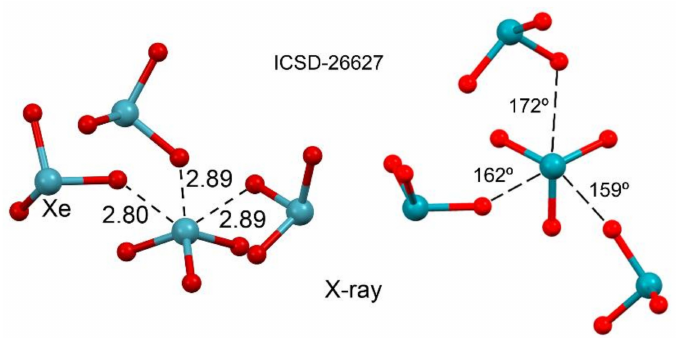
Figure 2. Ball and Stick representation of the X-ray structure (two views) of XeO 3 , refcode ICSD-26627. Distances in